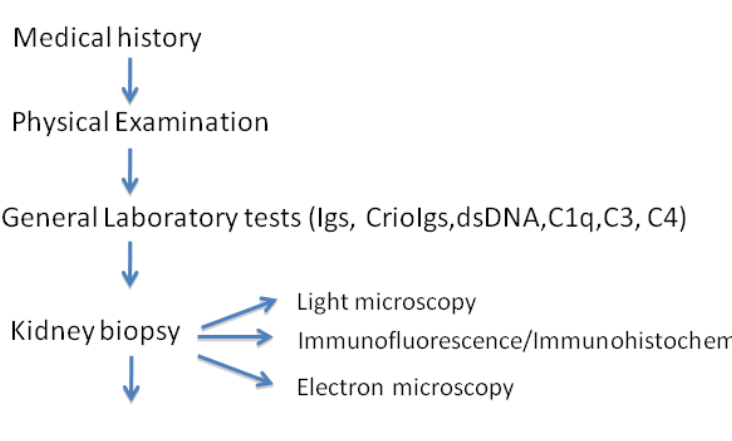
Figure 5. Clinical and Laboratory Work-up for diagnosis of C3 glomerulopathy.